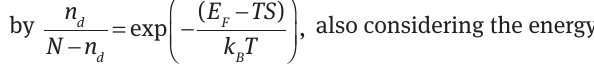
Figure 4: Identification of charged states in FLGs. Argon ion based plasma processing was used to purposefully create and then identify defects (such as dangling bond-rich edge plane defects of the armchair or zigzag varieties) and their contribution to capaci- tance and energy storage, in FLG structures. (Figure adapted from Reference [27] and reproduced with permission from the American Chemical Society,